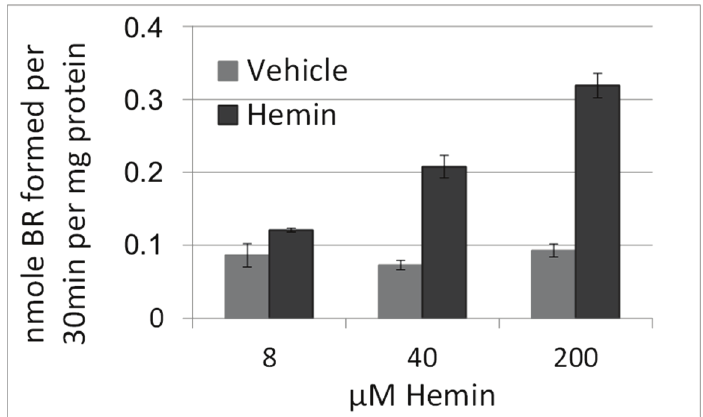
Figure 2. HO activity in hepatocytes after treatment with hemin. Cells were treated with vehicle (DMSO, grey bars) or hemin (8, 40, 200 μM, black bars) for 16 h. HO activity was determined in homogenized cells as described in the Materials and Methods